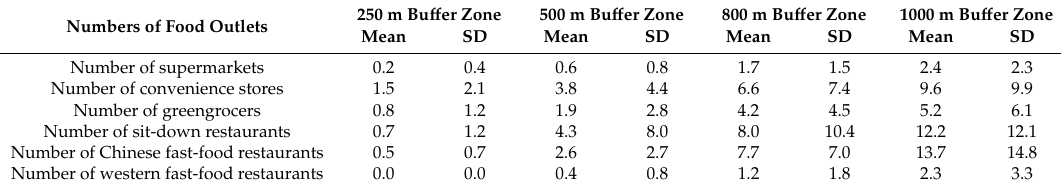
Table 2. Participants’ neighborhood food environment density characteristics.